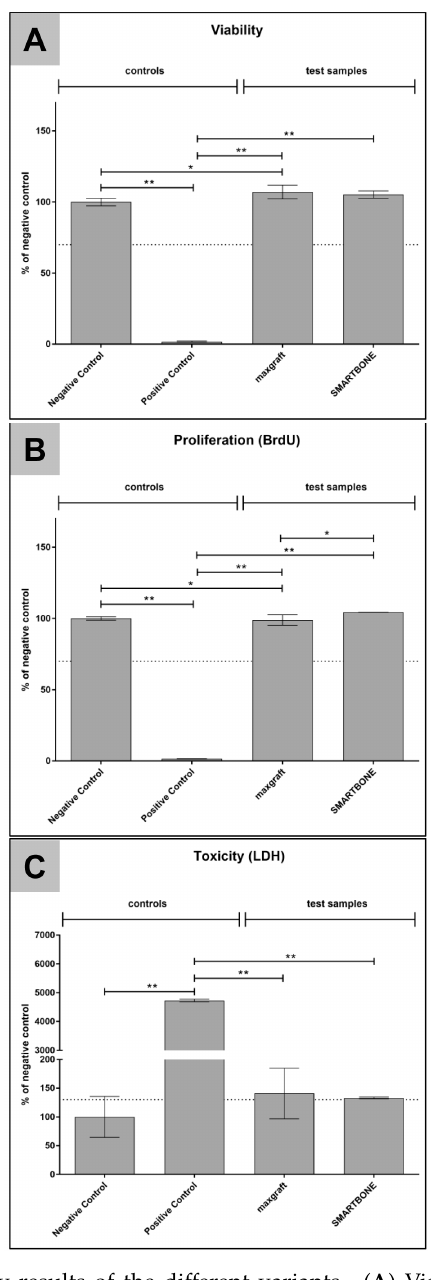
Figure 4. Cytocompatibility results of the different variants. ( A ) Viability measured by a BrdU assay; ( B ) proliferation measured by a Sodium 3,3 ′ -[1(phenylamino)carbonyl]-3,4-tetrazolium]-3is(4-methoxy-6-nitro) benzene sulfonic acid hydrate (XTT)-assay; ( C ) cytotoxicity measured by a lactate dehydrogenase (LDH) assay. Values are normalized against the respective negative control. Means with error bars indicate standard deviations. The dotted line indicates thresholds which should not be exceeded (LDH) or fall below (XTT; BrdU). Significant differences are indicated as described in the results section.